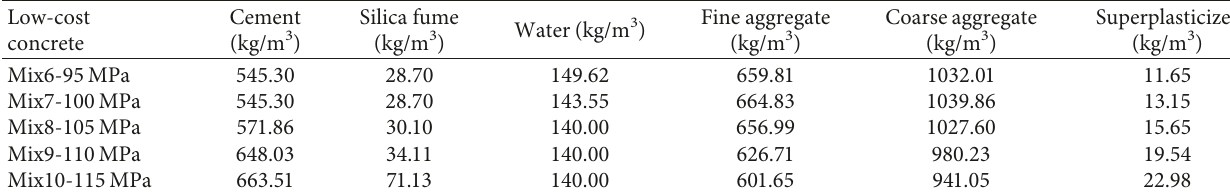
Table 7: Mixtures of low-cost high-strength concrete.